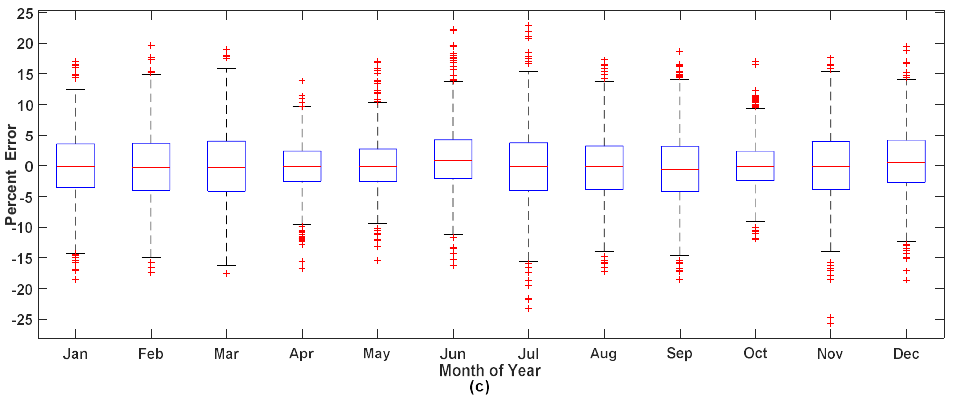
Figure 10. Breakdown of error statistics for load predictions ( a ) hourly, ( b ) weekly and ( c )